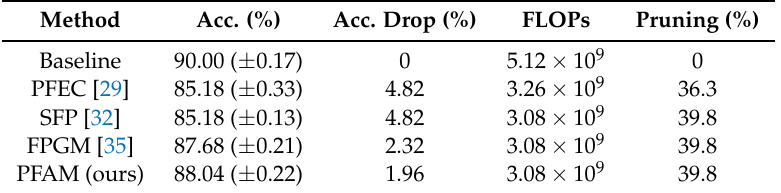
Table 5. Comparison of pruning VGG-16 on the RSSCN7 dataset.